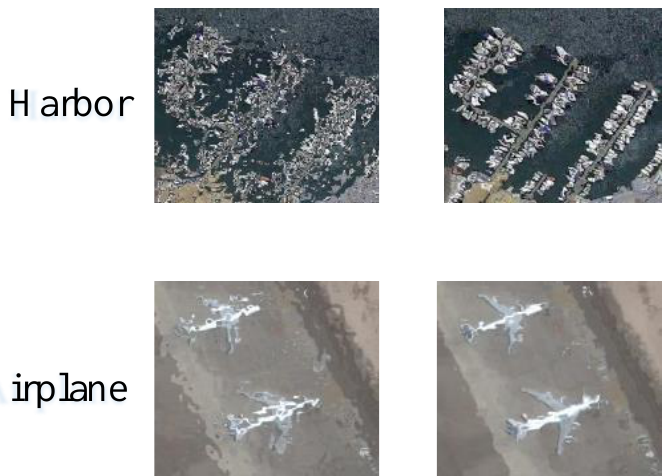
Figure 11. The samples generated by the model are affected by different random noise and category information. The first row represents the lock random noise rn and the changed category information ci , and the second row represents the changed random noise rn and the lock category information rn